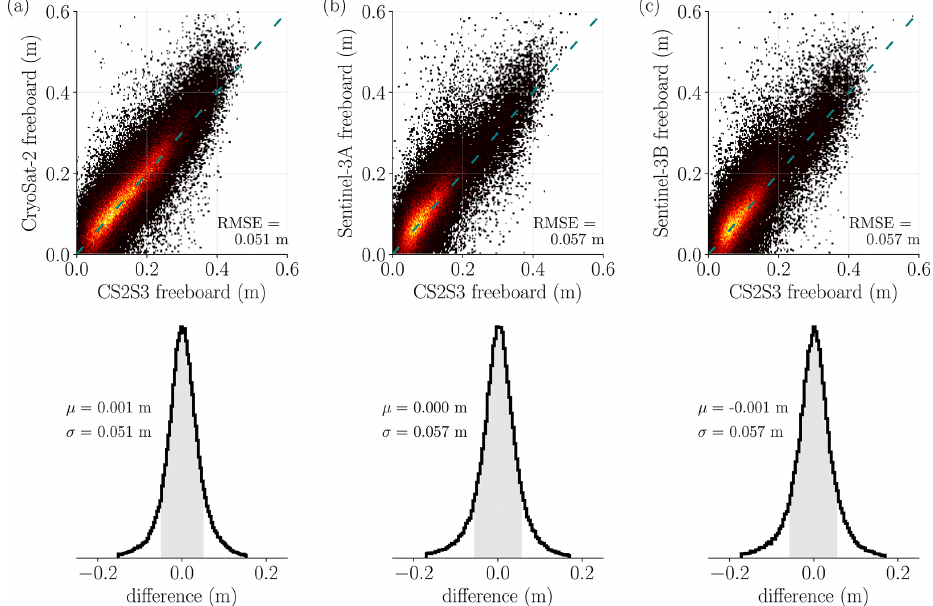
Figure 5. Comparison of daily gridded CS2S3 freeboard against daily (a) CS2, (b) S3A, and (c) S3B gridded freeboard tracks, for all days between the 1 December 2018 and the 24 April 2019. In each case, the freeboard values are directly compared in the scatter–density plot (dashed line shows y = x ). The distribution of the error is given by the histograms below each scatter plot (1 σ either side of the mean µ is shaded in grey). Only values within ± 3 σ of the mean are shown for the histogram